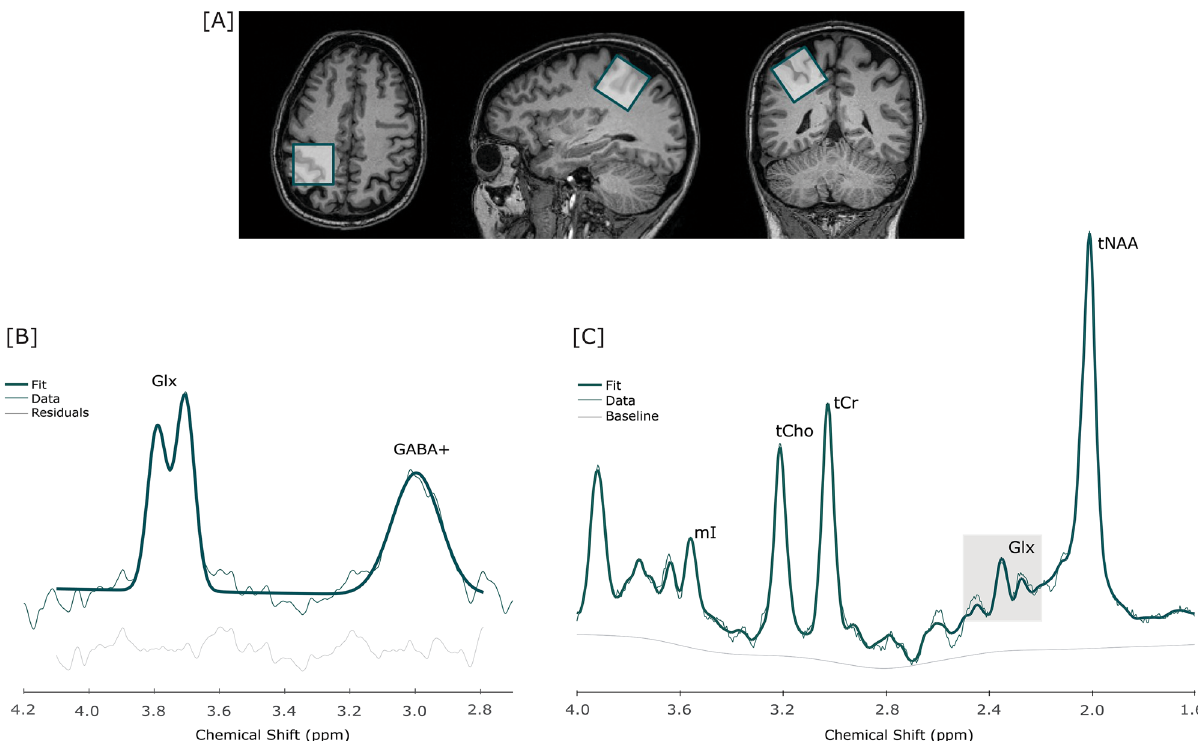
Figure 5. A schematic representation of the voxel placement ( A ). In ( B ), it is presented an example of Gannet output, from the HERMES sequence, used to estimate GABA+ concentration. Glx levels were quantified through the PRESS sequence acquisition, processed in LCModel, as represented by the example spectrum ( C ). Glx glutamate + glutamine, GABA+ gamma-aminobutyric acid, mI myo-inositol, tCho total choline, tCr total creatine, tNAA total N -acetylaspartate, ppm parts per